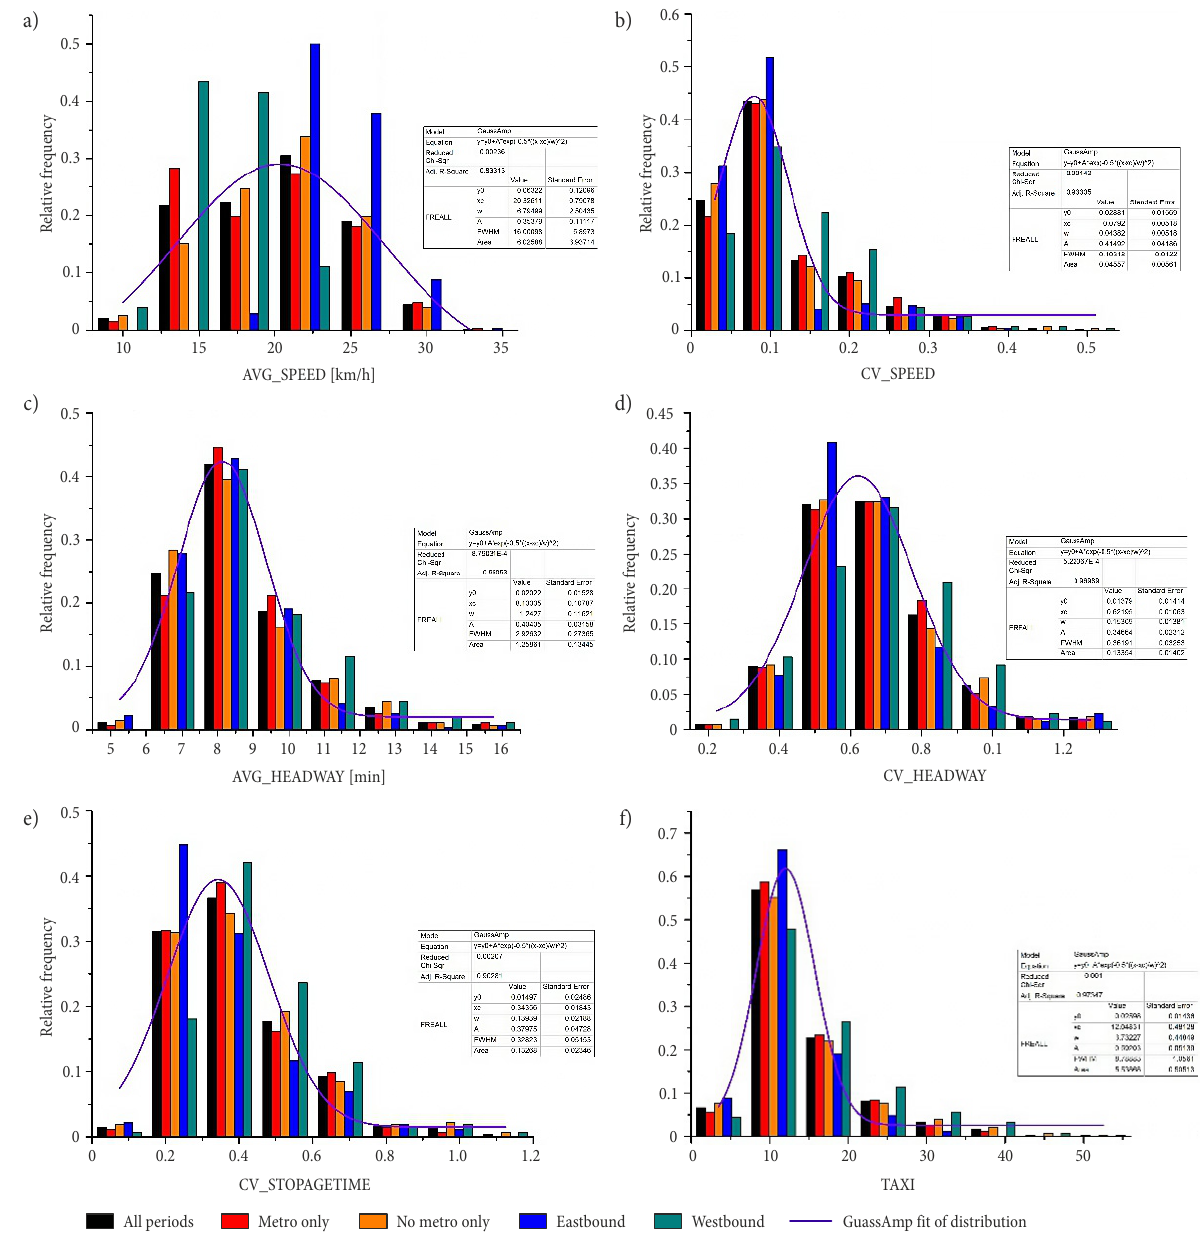
Figure 2. Descriptive statistics distribution of numerical variables: a – distribution of mean bus speed; b – distribution of coefficient of variability (CV) of bus speed; c – distribution of mean bus headway; d – distribution of CV of bus headway; e – distribution of CV of bus stoppage time; f – distribution of target taxis (the purple curve in each figure is fitting